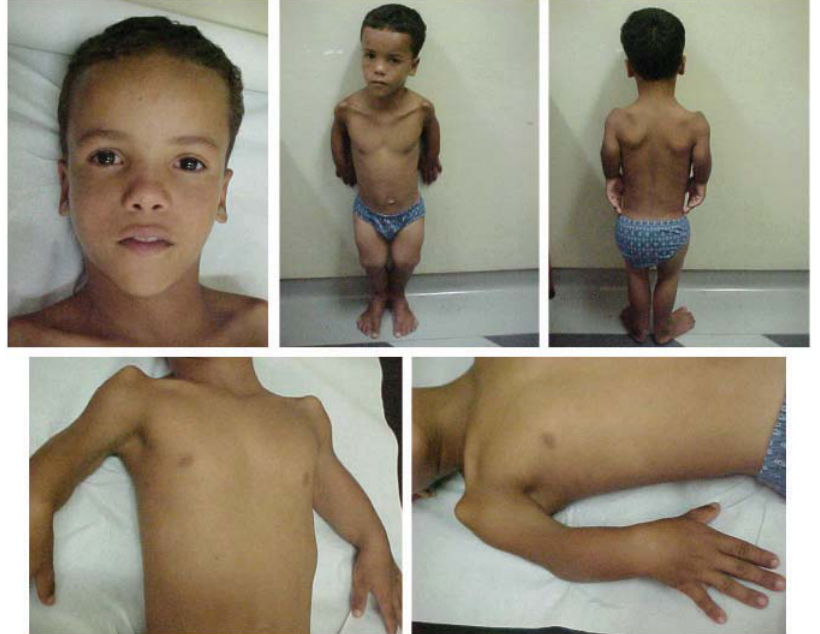
Fig. 1 – 9 year 3 month-old boy with short limbs, typical facies and limited extension of the elbows and knees.